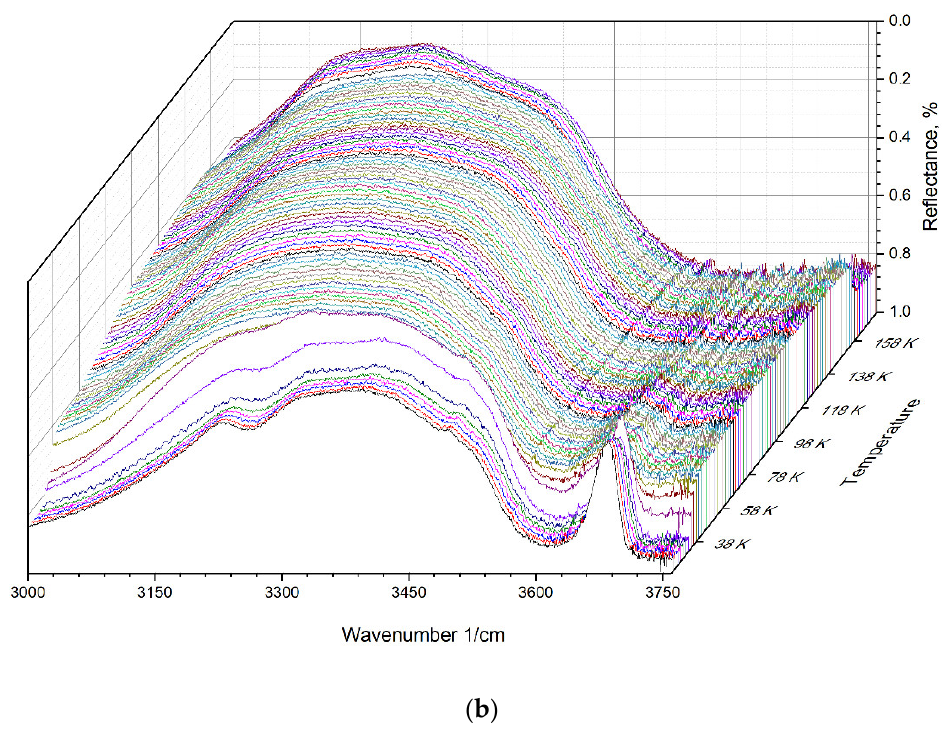
Figure A1. 3D IR spectra of a mixture of water and nitrogen deposited by PVD method in the tem- perature range from 20 to 165 K: ( а ) from 2100 to 2400 cm −1 ; ( b ) from 3000 to 3750 cm −1 .